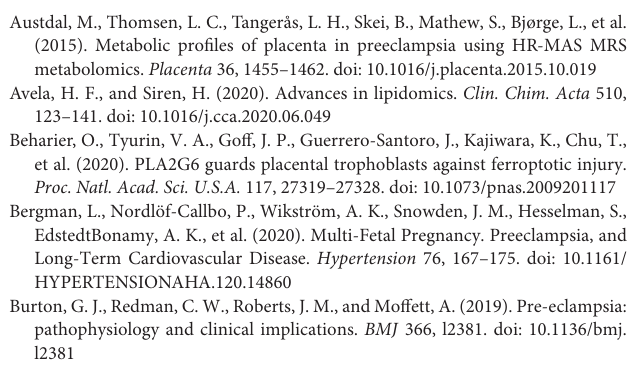
Supplementary Figure 1 | Determination of soft-threshold power in the WGCNA. (A) Analysis of the scale-free index for various soft-threshold powers ( β ). (B) Analysis of the mean connectivity for various soft-threshold powers. Supplementary Figure 2 | (A) The proportion of metabolites subclasses. (B) Thirty-three lipid classes identified in this study. Supplementary Figure 3 | (A,B) The expression of GSH and GSSG in control and preeclampsia group. Supplementary Figure 4 | (A,B) The expression of D-glucose 1-phosphate and 3-phospho-D-glycerate in control and preeclampsia group. Supplementary Figure 5 | (A–D) The ROC curve of Glycerophosphocholine, L-palmitoylcarnitine, Maltotriose, and five metabolites. Supplementary Figure 6 | (A–C) The ROC curve of SM(d36:1) + H, SM (d38:1) + H, and SM(d36:1) +